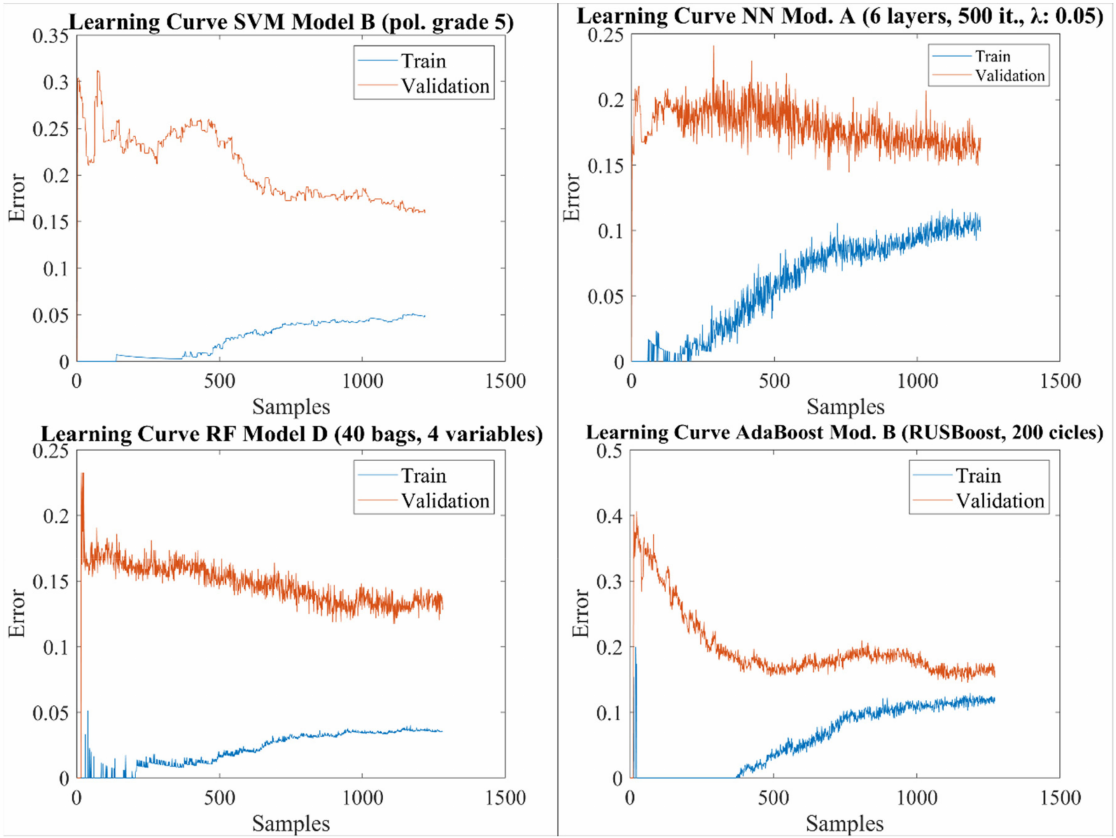
Figure 5. Learning curves for the best models (maximizing F1) for each machine learning